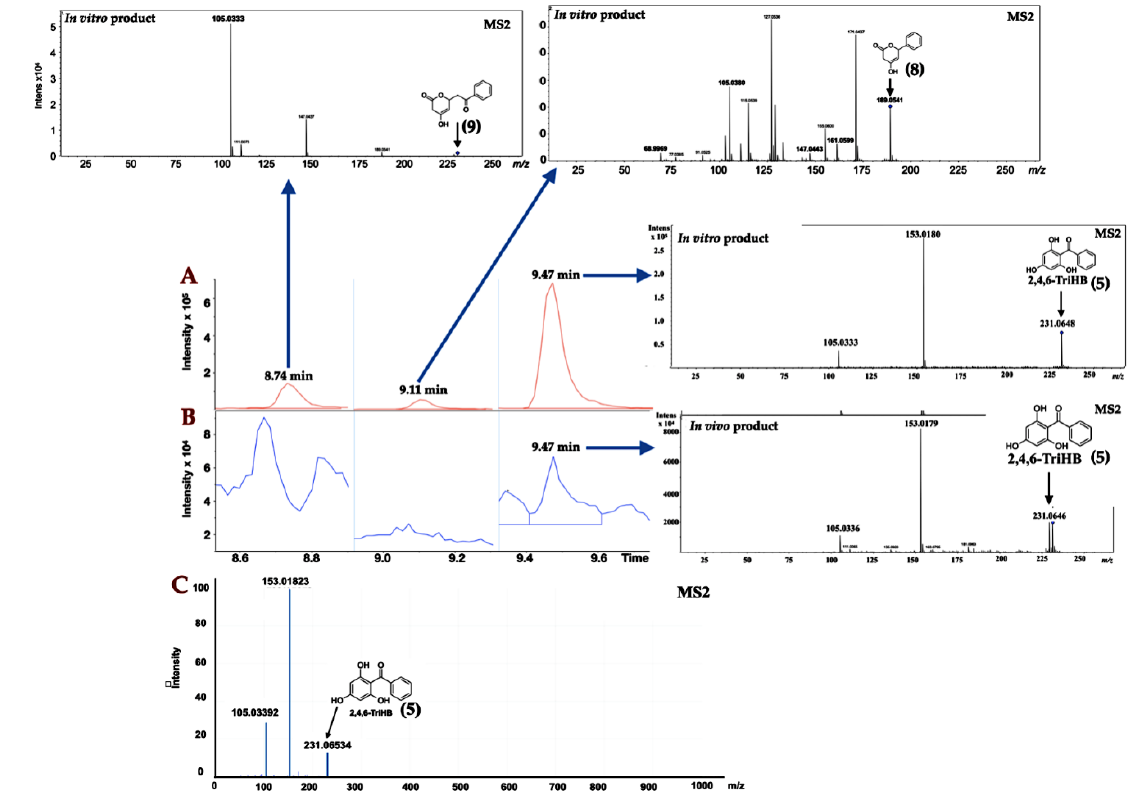
Figure 2. Identification of 2,4,6-TriHB ( 5 ) using the positive ion mode in LC-ESI-QTOF-MS/MS (CID of 20 eV) with multiple reaction monitoring (MRM) mode. ( A ) Selected regions of the total ion chromatogram (TIC) from the enzymatic products of GmBPS (red), which consisted of tetraketide lactone ( 9 ), triketide lactone ( 8 ), and 2,4,6-TriHB ( 5 ), with their unique MS/MS spectra that was obtained from the EICs (inserted pictures); ( B ) The regions of TIC of the secreted products from clones harboring pETDuet-BadA-GmBPS (blue) consisting only of the putative 2,4,6-TriHB peak ( 5 ) where the two ketide lactones ( 8 , 9 ) were absent; ( C ) The MS/MS spectra of the standard 2,4,6-TriHB ( 5 ) analyzed by the LC-ESI(+)-QFT technique, retrieved from the PubChem database (submitted by Megan Showalter, University of California, Davis ).